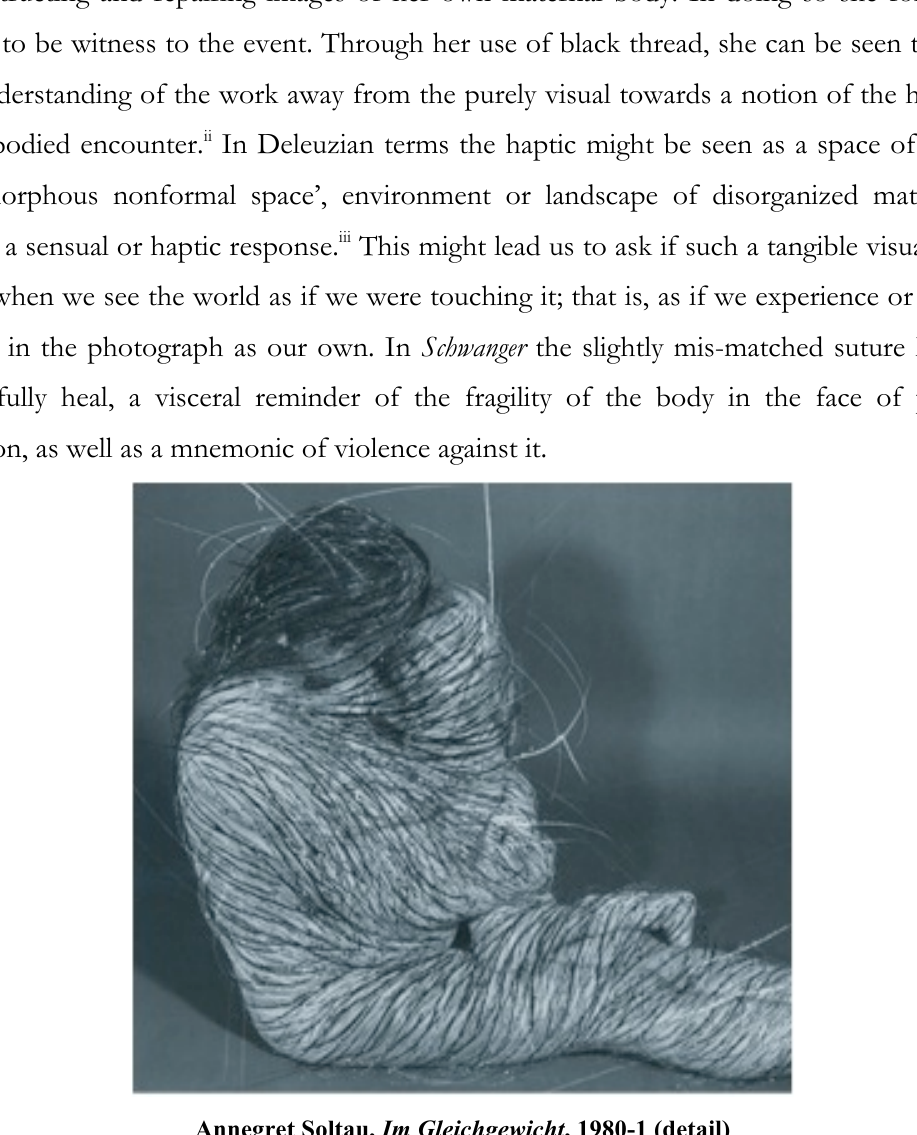
Heather Hanna, A Visual Essay: Interventions and Manipulations in the Maternal Studies in the Maternal, 4(1), 2012,